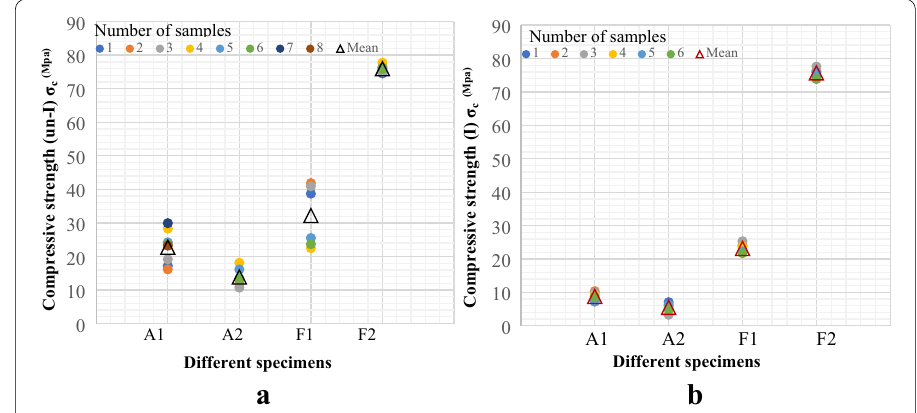
Fig. 5 a compressive strength of dry specimens according to different facies. b Compressive strength of water immersed specimens according to the different